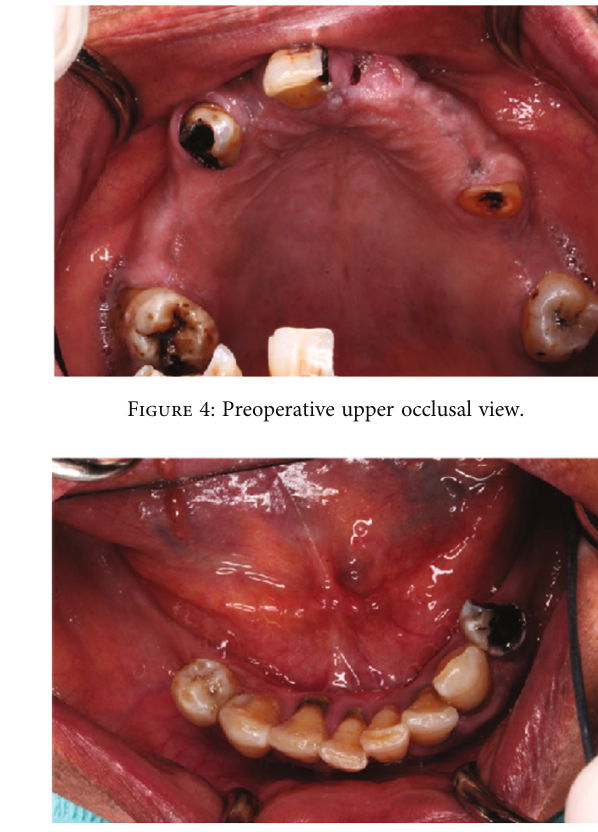
Figure 5: Preoperative lower occlusal